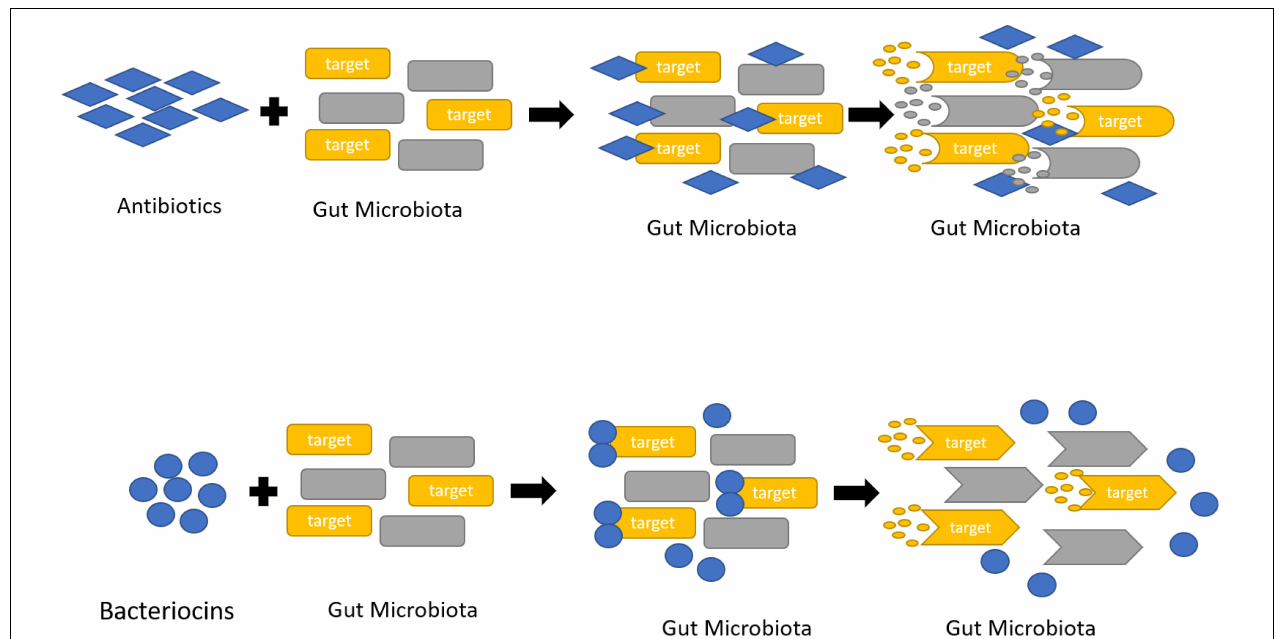
FIGURE 3 | Killing mechanism of antibiotics and bacteriocins against gut